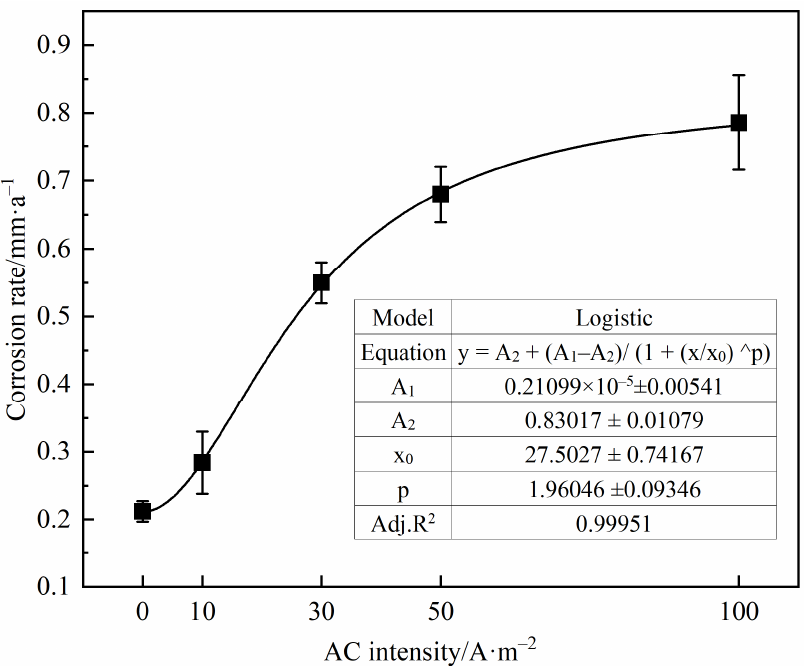
Figure 5. Weight loss results of the steel in the galvanic couple interfered with different AC intensities in simulated acidic red soil.